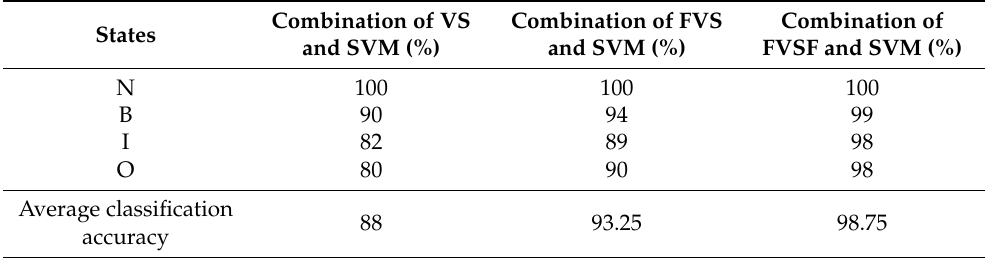
Table 5. Comparison of the combination of VS and SVM, the combination of FVS and SVM, and the combination of the proposed FVSF and SVM for bearing data classification.